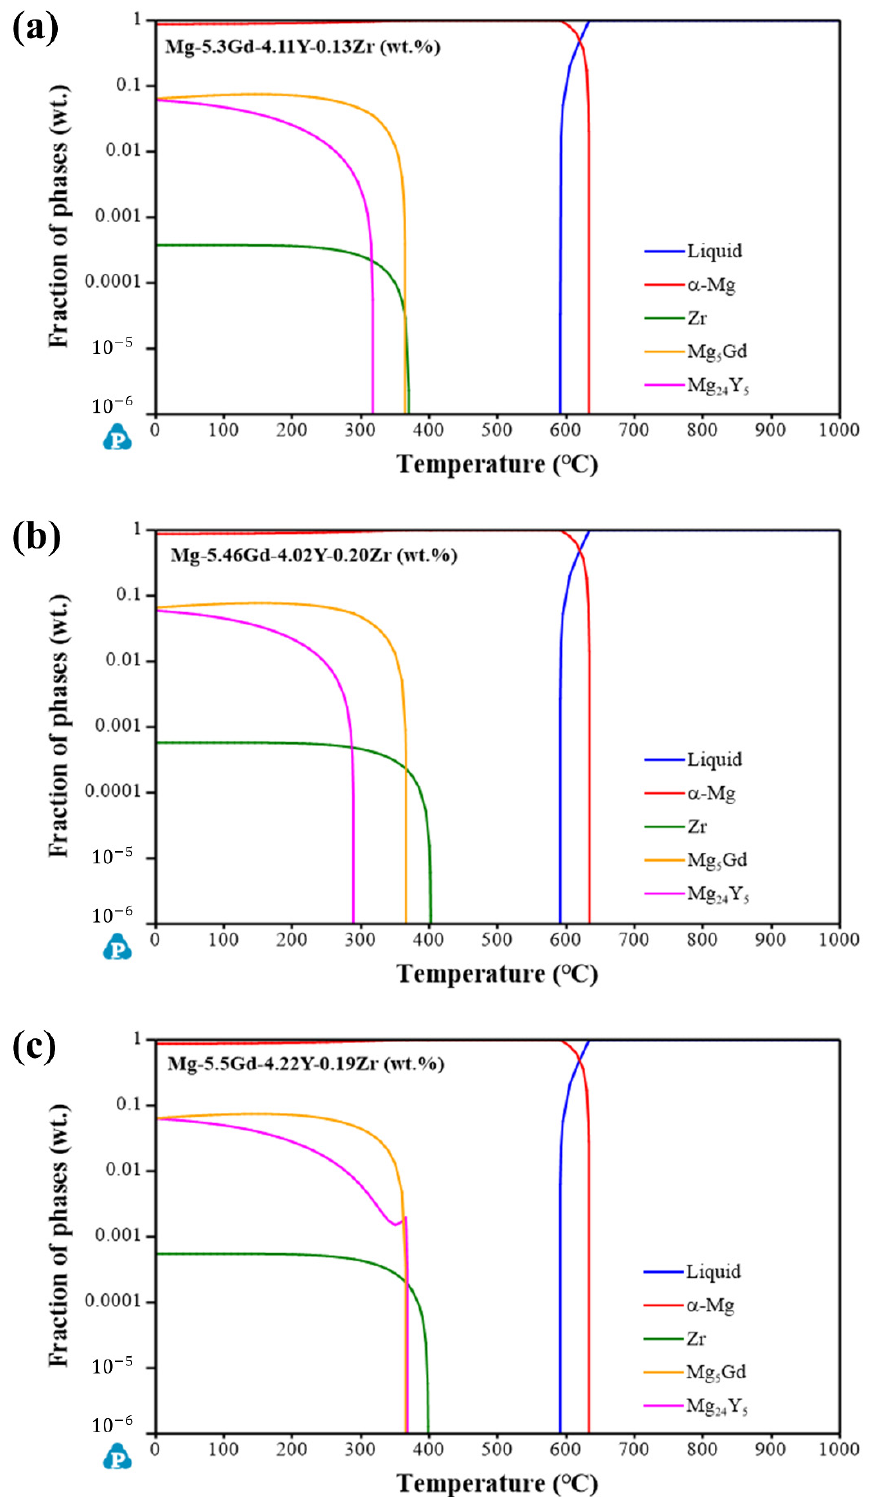
Figure 5. Solidification behavior of ( a ) GWK-a; ( b ) GWK-b; ( c ) GWK-c alloys.